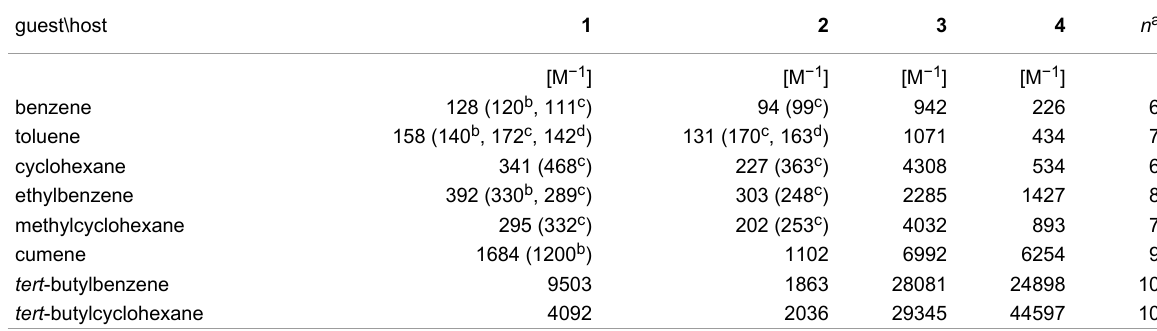
Table 1: Binding constants K of benzene and cyclohexane derivatives in β -CD and β -CD derivatives as determined from HS-GC peak areas according to Equation 1. guest\host